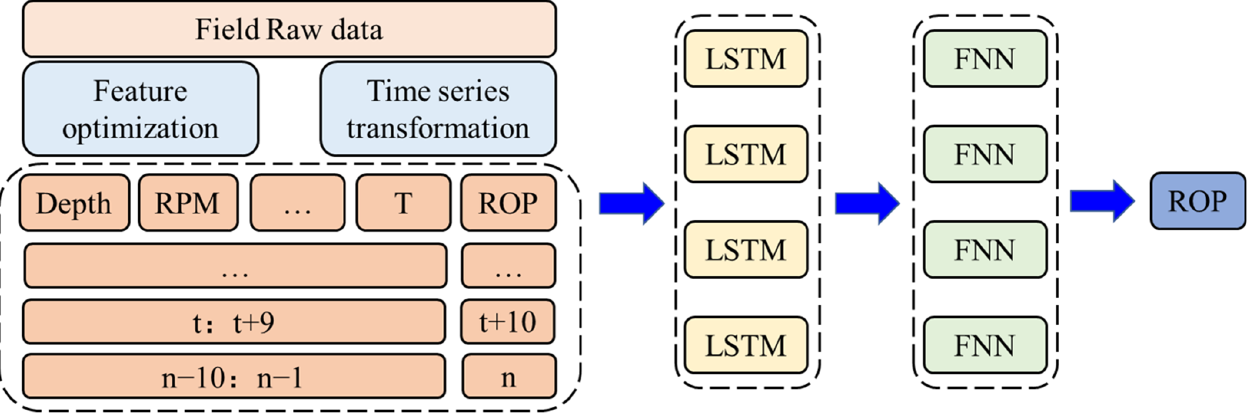
Figure 6. LSTM–FNN network framework.